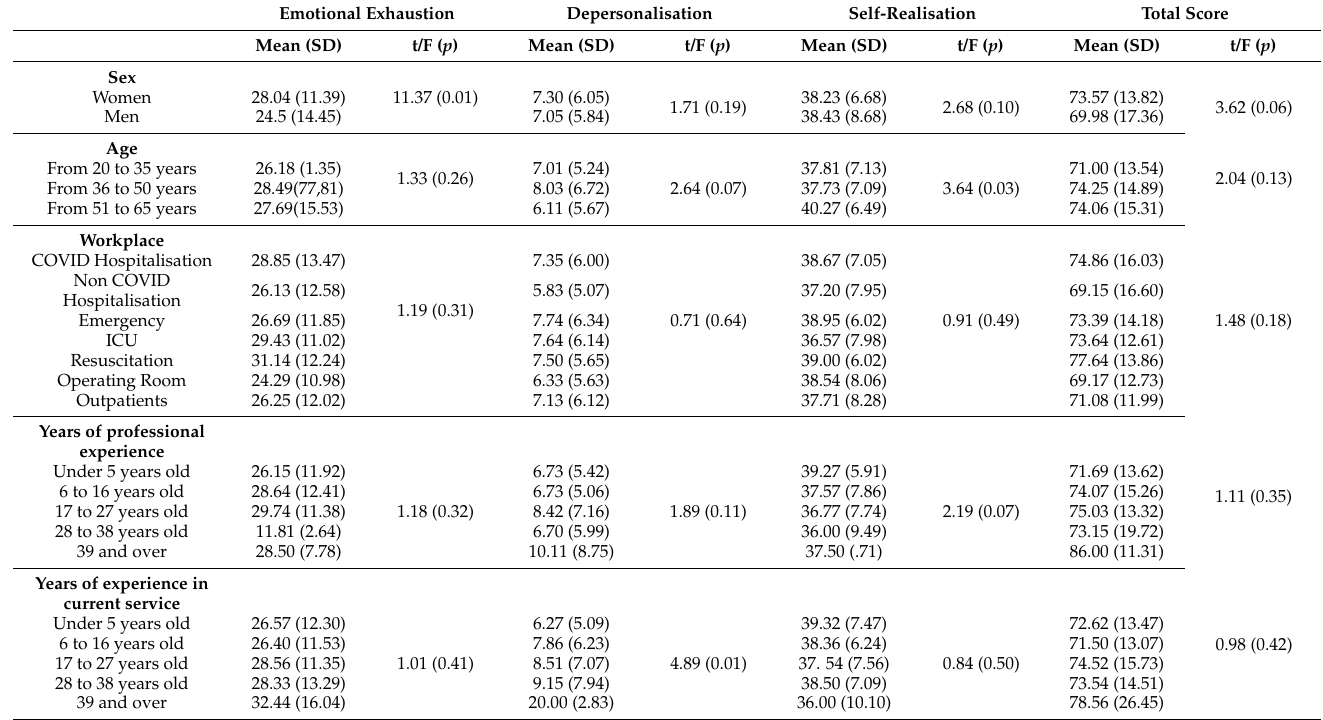
Table 3. Burnout, socio-demographic and occupational